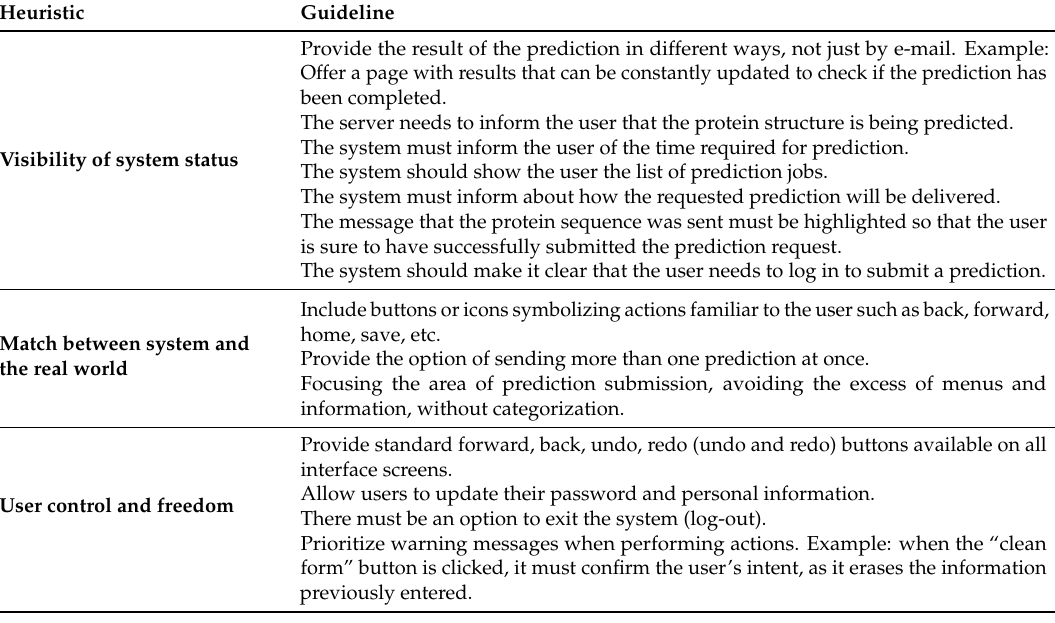
Table 9. Specific guidelines for designing bioinformatics